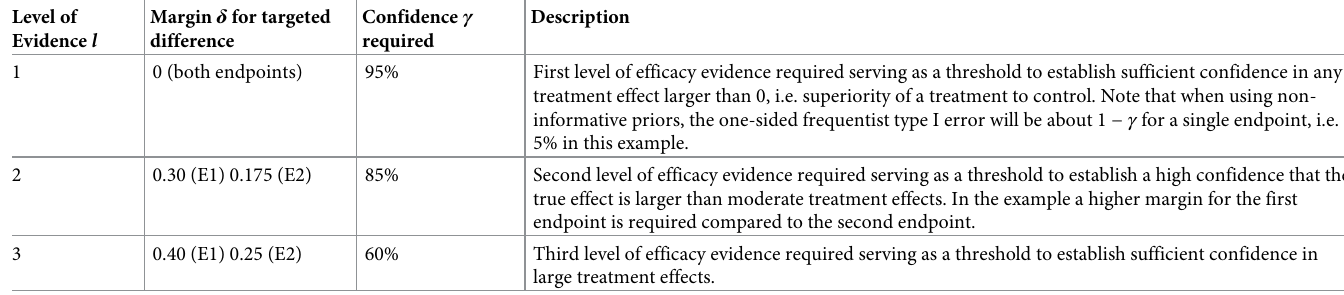
Table 2. Different levels of evidence required to graduate treatment for efficacy. The ordering is hierarchical in nature, i.e. requiring two levels of evidence means level 1 and level 2 need to be simultaneously fulfilled. E1 and E2 refer to endpoint 1 (resolution of NASH without worsening of fibrosis) and endpoint 2 (1-stage fibrosis improvement without worsening of NASH) respectively.